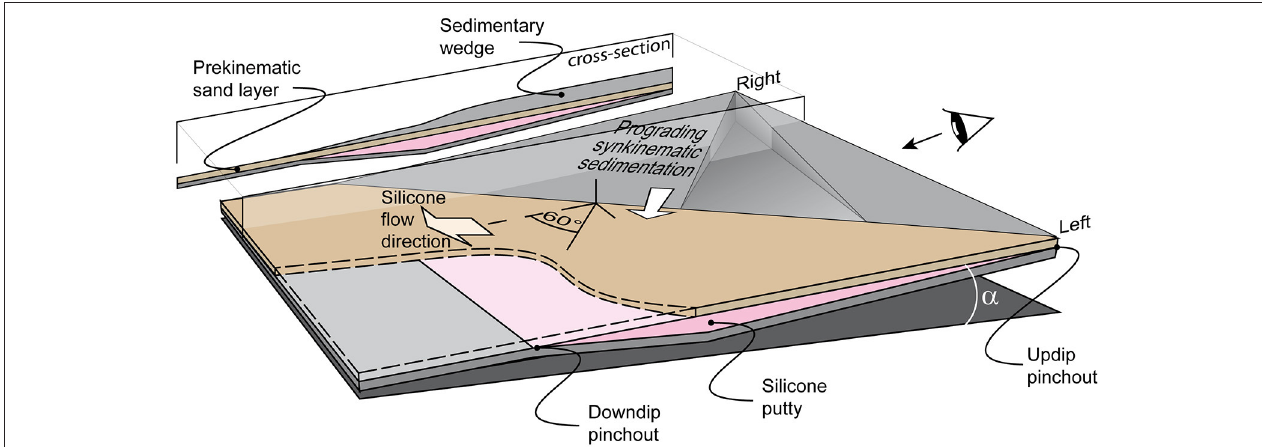
FIGURE 4 | Tri-dimensional sketch of the experimental setting used to study the growth of a continental shelf in a salt tectonic environment where the sediment supply (white arrow) is oblique to salt flow. The basal layer of silicone putty (pink) is double-wedge shaped to simulate salt pinch-out at the updip and downdip ends of the salt basin. A thin sand layer is deposited on top of the silicone layer before the onset of experiment. The direction of salt flow is obtained in inclining the model by an angle α . The obliquity between sediment supply and salt flow is 60 ◦